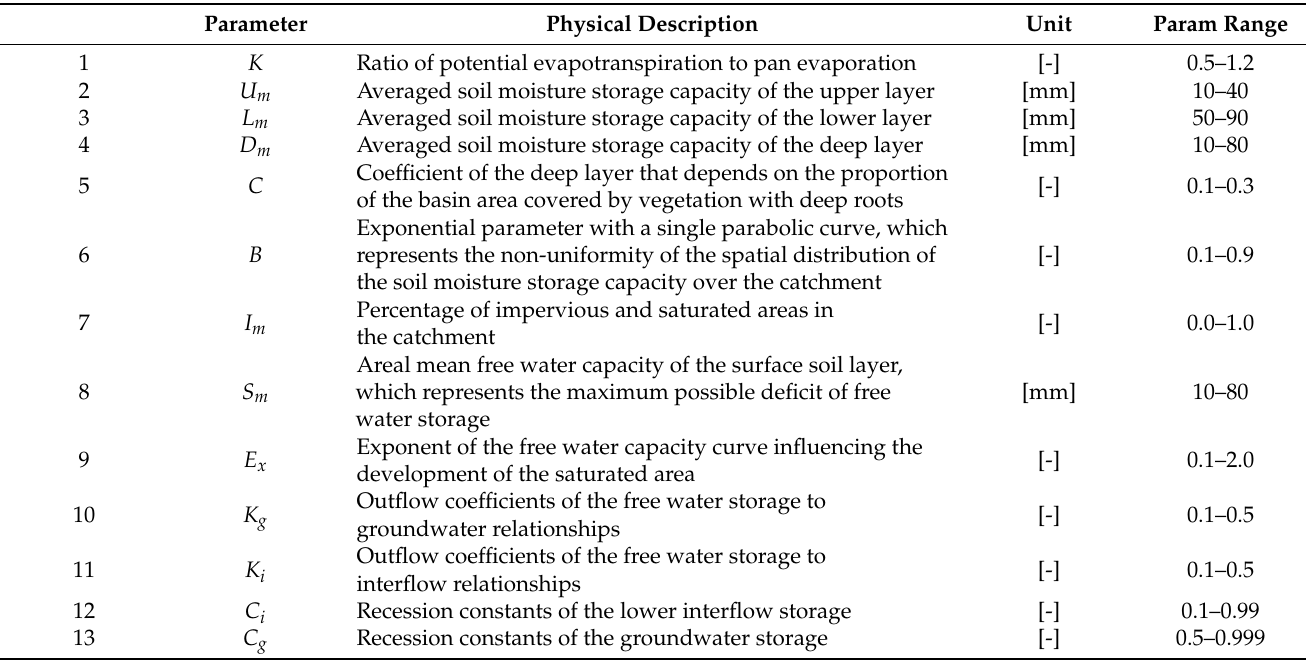
Table 2. Physical meanings and units of model